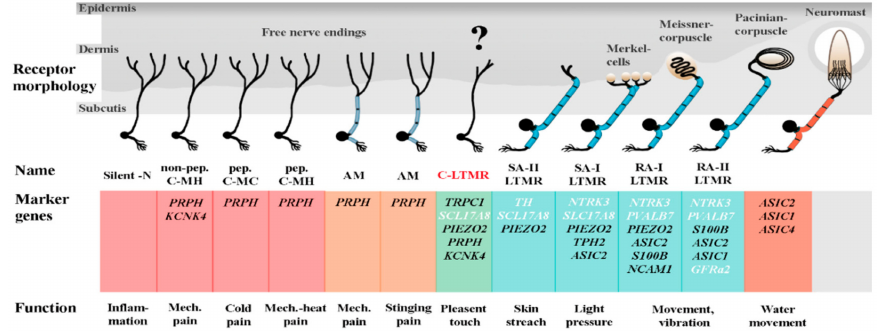
Figure 5. Summary of the possible presence of somatosensory receptors in the adipose fin of rainbow trout. Listed are the genes indicating the presence of nociceptors with free nerve endings (red, orange) and with specialized receptor structures (green) and cutaneous LTRMs with receptor corpuscles (blue) as well as neuromasts (light red). Marker genes identified in the adipose fin in ample amounts are printed in black. Marker gene names are printed in white if the expression in the AF was not outstandingly high in the comparison of the tissues analyzed. The specific cell types for which the listed genes are characteristic are labeled as follows: Non-peptideric C-fibre mechano-heat receptor (non-pep.-C-MH), peptideric mechano-cold nociceptor (pep. C-MC), peptideric C-fibre mechano-heat nociceptor (pep. C-MH), A-fibre mechanonociceptor (AM), C-fiber low-threshold mechanoreceptor (C-LTMR), A β -fiber slowly-adapting type I and type II LTMR (SA-I LTMR and SA-II LTMR), A β -fibre rapidly-adapting type I and type II LTMR (RA-I LTMR and RA-II LTMR). Marker genes were